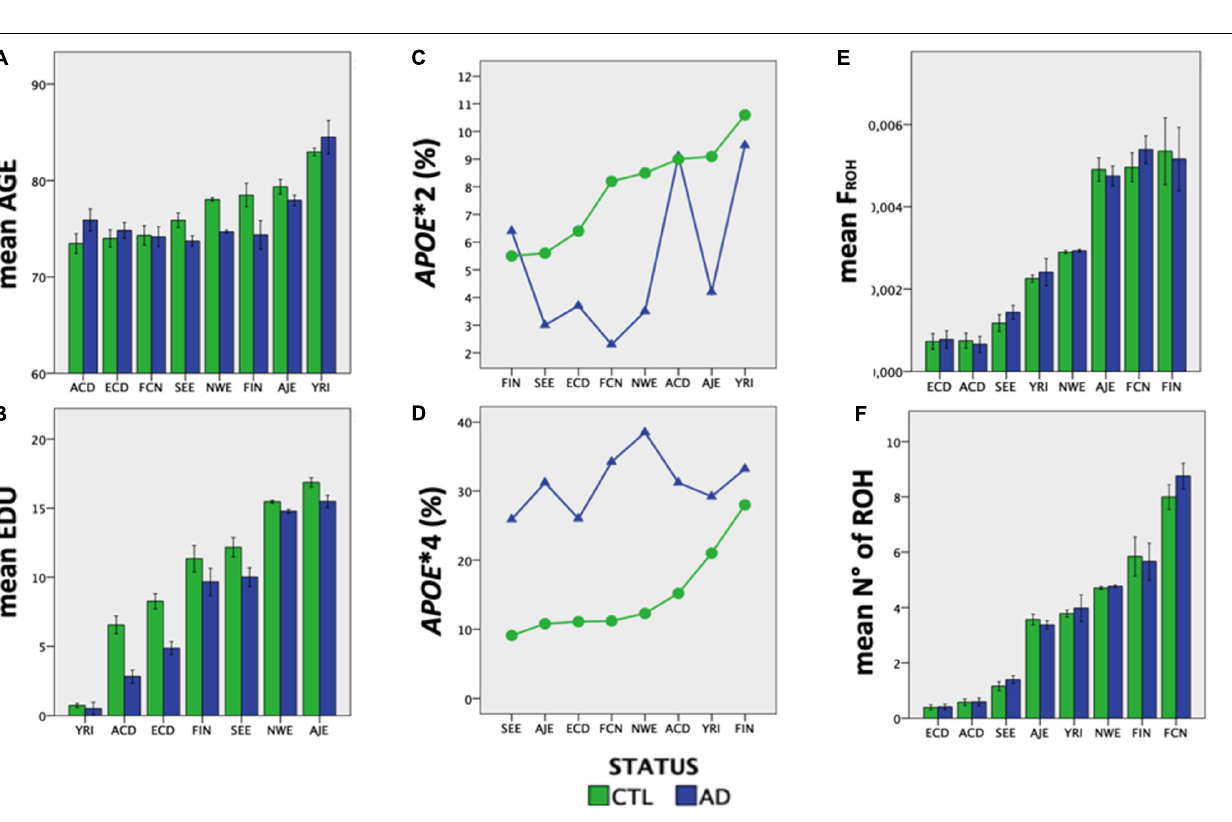
FIGURE 3 | The eight ethnic groups analyzed showed ethnic-specific differences in Alzheimer’s-relevant risk factors. (A) mean age, (B) EDU, (C) APOE ∗ 2 frequency, (D) APOE ∗ 4 frequency, (E) inbreeding coefficient, and (F) number of ROHs ( > 1 Mb) differ significantly across the eight ethnic groups analyzed ( P <